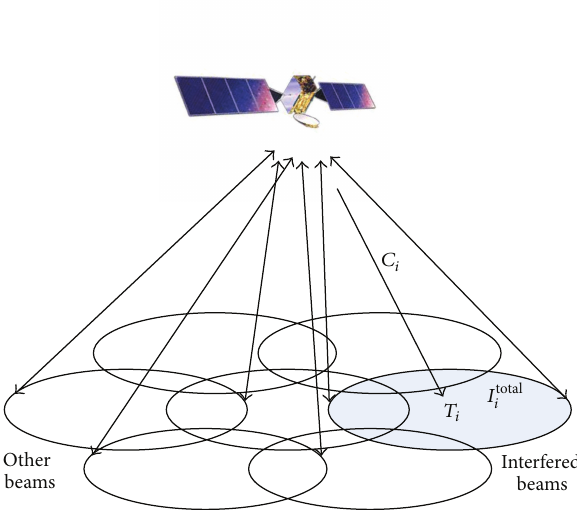
Figure 1: Configuration of the multibeam satellite communication